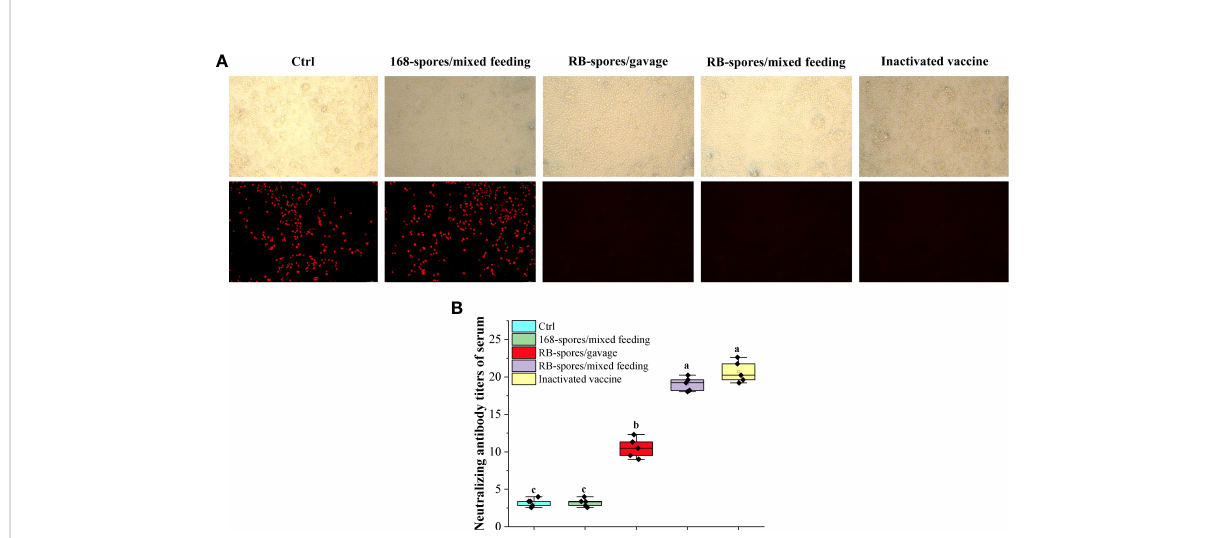
FIGURE 5 Virus microneutralization test. (A) Sera from each group were co-incubated with 50 m L of 200 TCID50 of PCV2 and then inoculated with pre- cultured PK15 and grown to 72h for indirect immuno fl uorescence assay. The fi gures in the upper row represent the morphology of cells in the bright fi eld of fl uorescence microscopy. The second row indicates the cells in the fl uorescent fi eld of view. (Magni fi cation of 20×) (B) Determination of neutralizing antibody titers in serum of each group by Reed-Muench method. Spores displaying heterologous antigens on the surface could induce high titers of serum neutralizing antibodies. Data are presented as means ± standard deviation (n=5). One-way ANOVA followed by a Friedman test was performed, bars with different letters indicate signi fi cant difference ( P < 0.05).